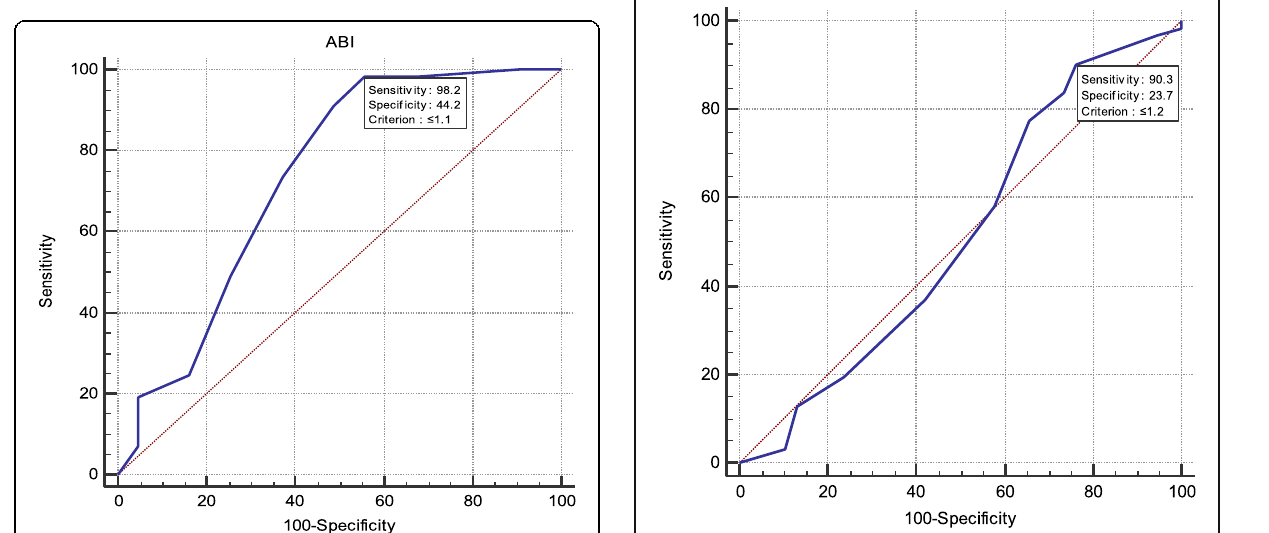
Fig. 4 High sensitivity of central DBP with ABI